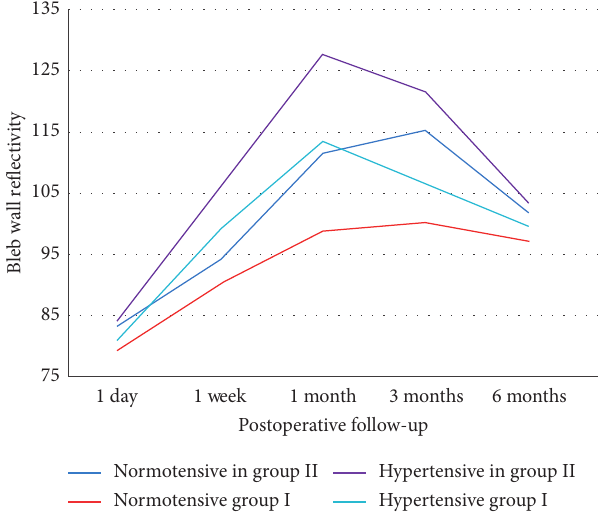
Figure 2: Inverted U-shaped pattern of the mean maximal bleb wall reflectivity. Table 8: Correlation between maximal bleb wall thickness and maximal bleb wall reflectivity in studied groups. Postoperative follow-up